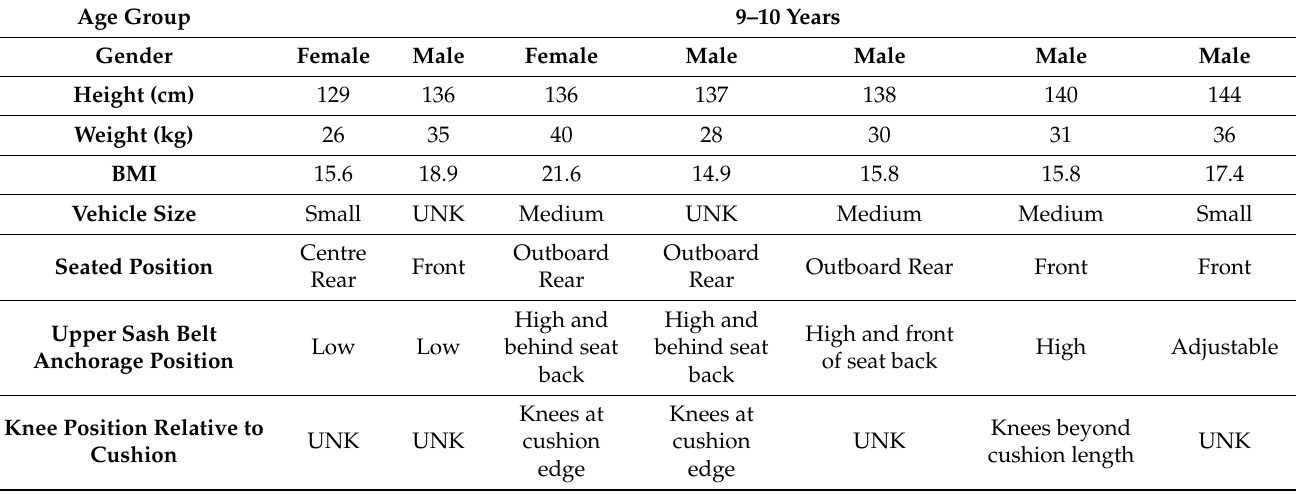
Table 4. Demographic and vehicle factors for cases shorter and lighter than cut-offs, who achieved a good seat belt fit.